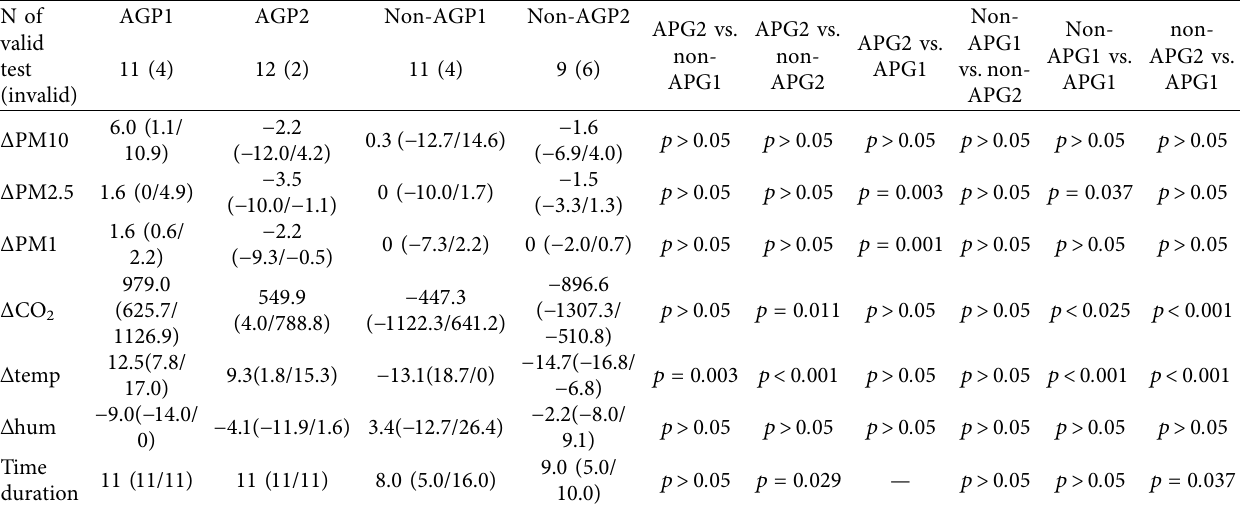
Table 1: . Results of Δ PM (ug/m3), Δ CO 2 concentration (ppm), time duration (in minutes), Δ temperature (K), and different observation phases per